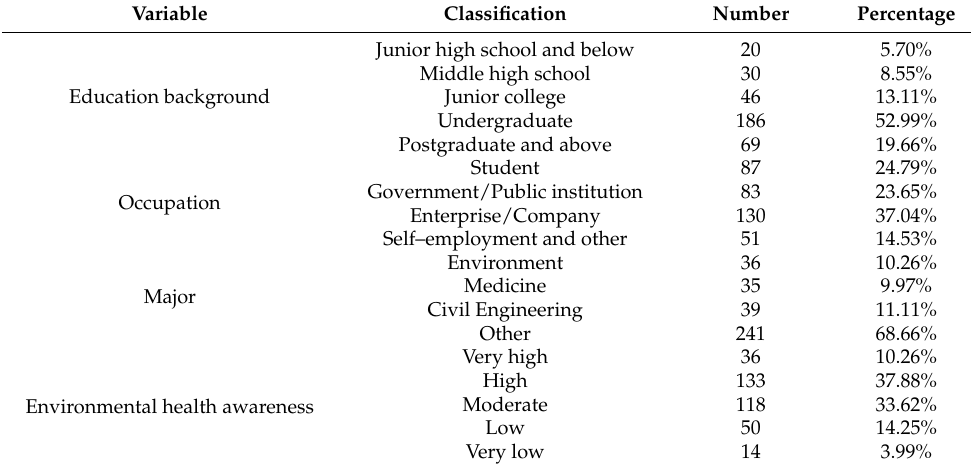
Table 2. Knowledge structure of respondents.